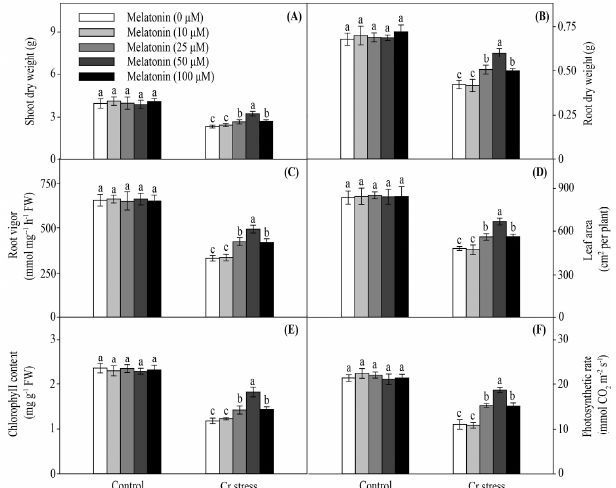
Figure 1. Effect of melatonin on shoot dry weight ( A ), root dry weight ( B ), root vigor ( C ), leaf area ( D ), chlorophyll content ( E ), and photosynthetic rate ( F ) in maize under Cr stress. The different letters denote significant differences at p < 0.05. Data are shown as mean ± SE ( n = 3).